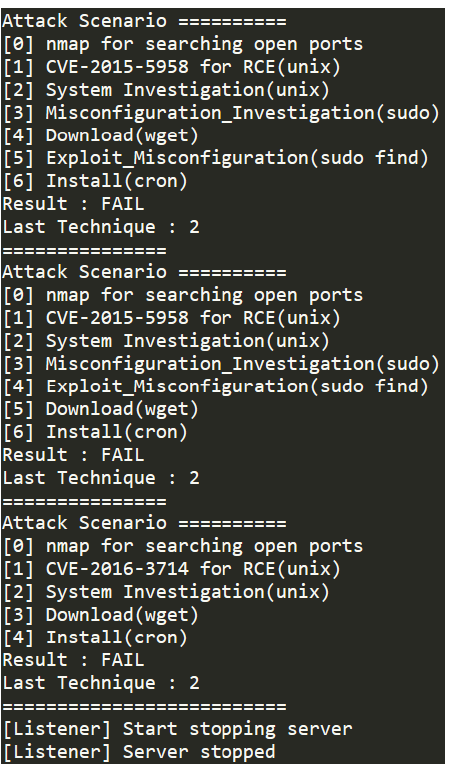
Figure 20. An example of the failure of all